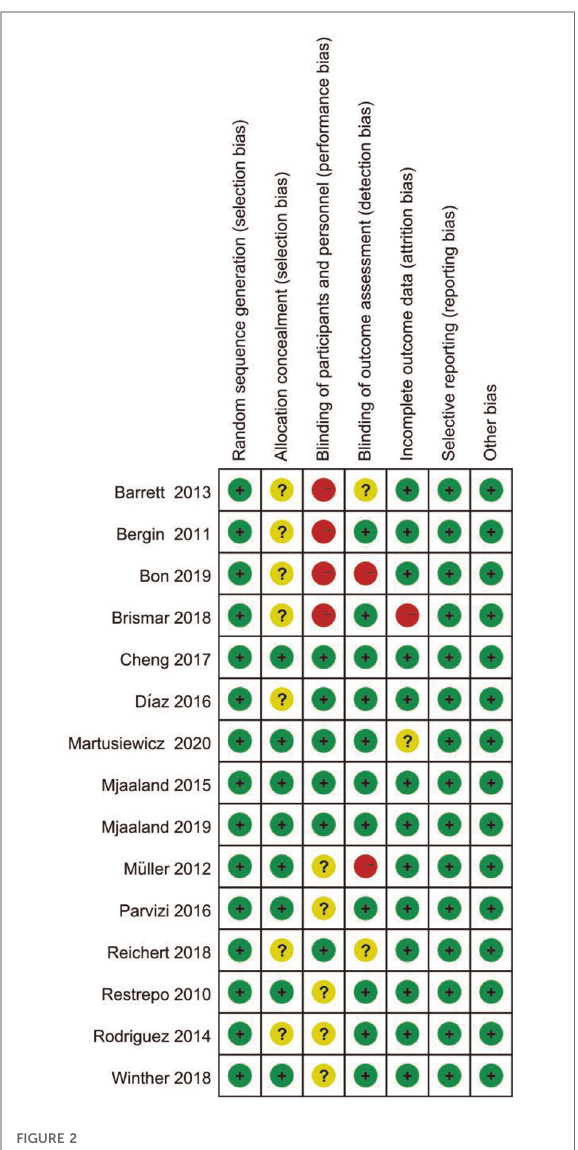
FIGURE 2 The quality assessment of each